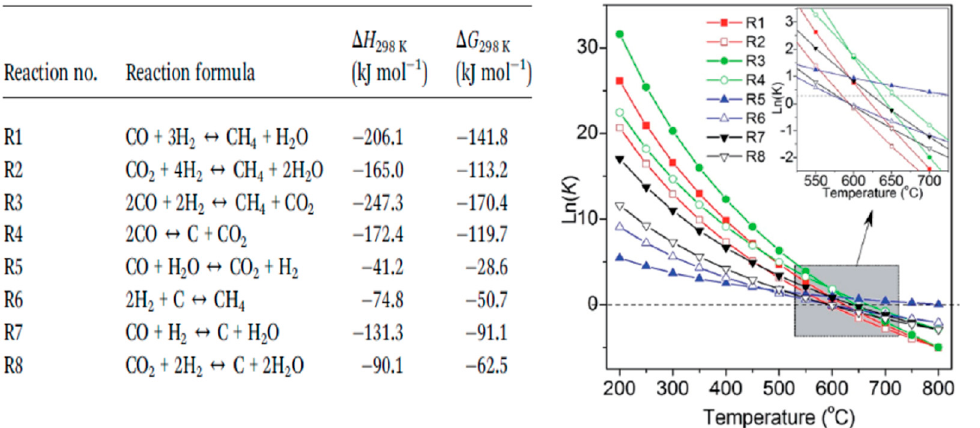
Figure 4. The reactions that are involved in CO 2 methanation and their calculated thermodynamic equilibrium constants. A significant decrease of K vs. temperature can be observed. © Adopted from [89,93].